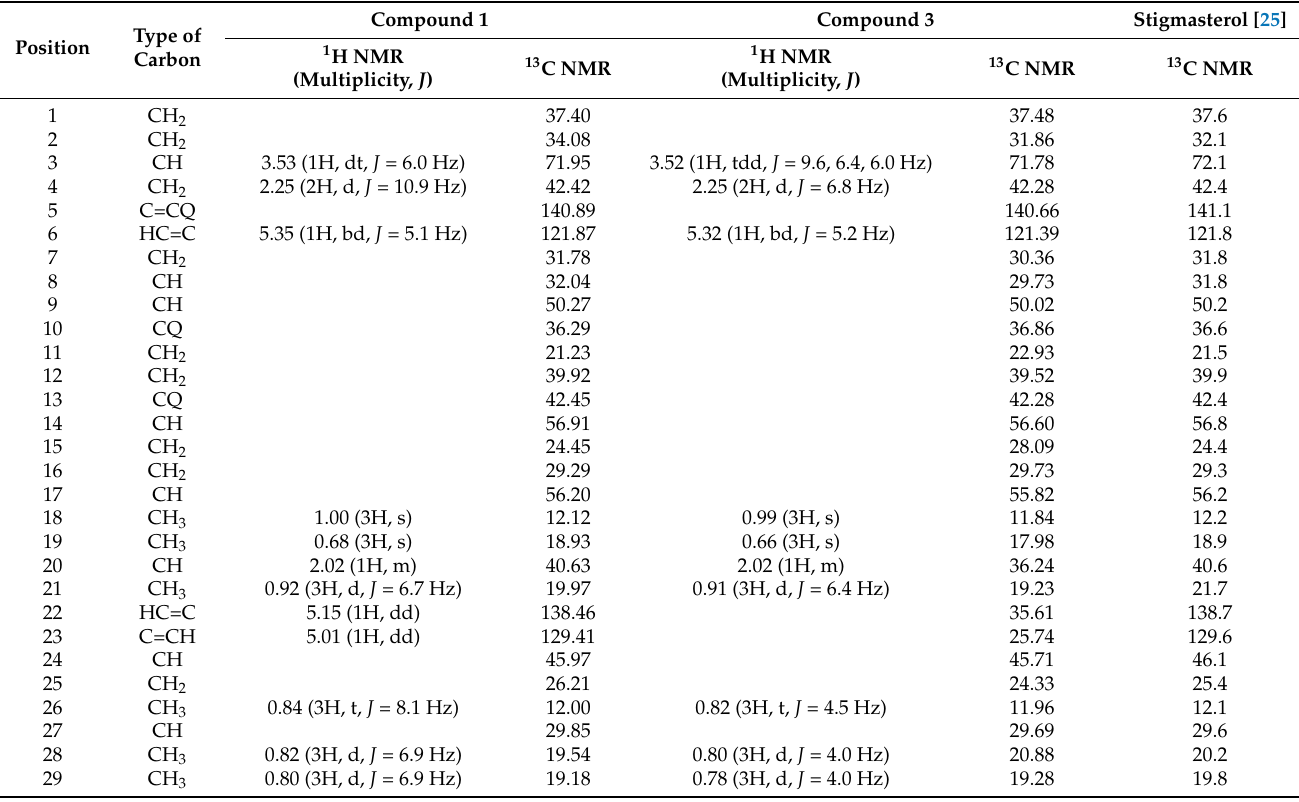
Key: The chemical shifts of proton and carbon NMR signals are represented in parts per million (ppm) in deuterated chloroform; multiplicity: s, d, dd, dt, m, bs, tdd and t stand for a singlet, doublet, doublet of a doublet, doublet of a triplet, multiplet, broad singlet, triplet of a doublet of a doublet, and triplet, respectively; coupling constant ( J ) is expressed in Hertz (Hz); methyl (CH 3 ); methylene (CH 2 ); methine (CH); quaternary carbon